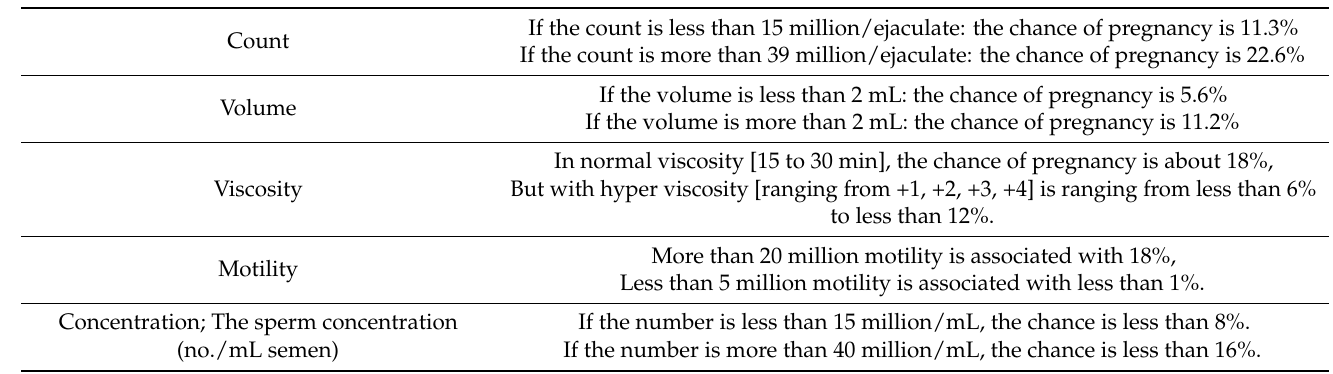
Table 1. The effect of the seminal fluid analysis in the success rate of pregnancy [2]. If the count is less than 15 million/ejaculate: the chance of pregnancy is 11.3% Count If the count is more than 39 million/ejaculate: the chance of pregnancy is 22.6% If the volume is less than 2 mL: the chance of pregnancy is 5.6% Volume If the volume is more than 2 mL: the chance of pregnancy is 11.2% In normal viscosity [15 to 30 min], the chance of pregnancy is about Viscosity